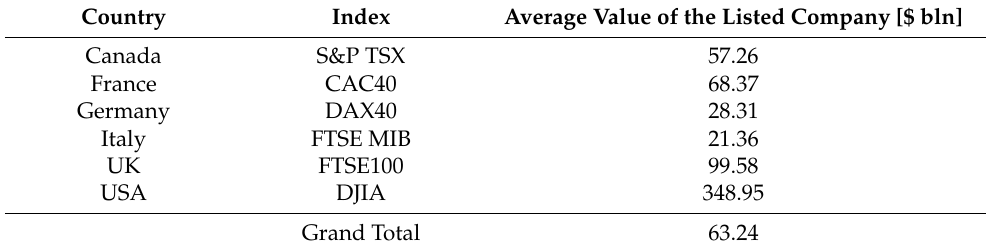
Table 3. Average value of a listed company in the given group of the Energy and Utilities sector. Country